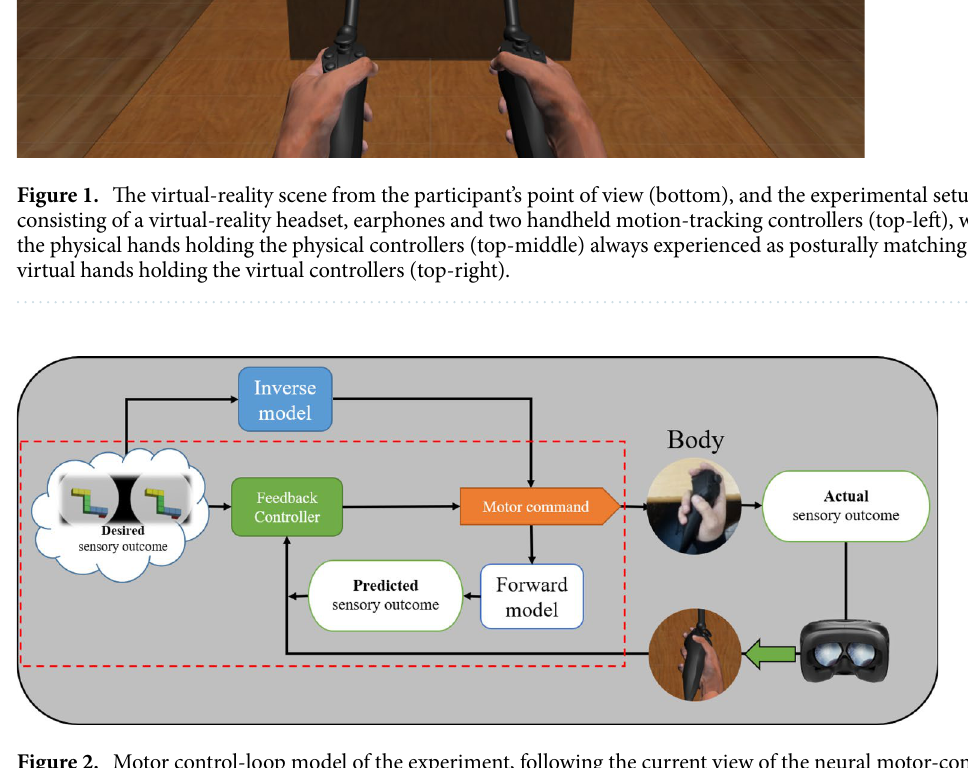
Figure 2. Motor control-loop model of the experiment, following the current view of the neural motor-control feedback loop combining Forward and Inverse models. The red rectangle marks the assumed planning/imagery